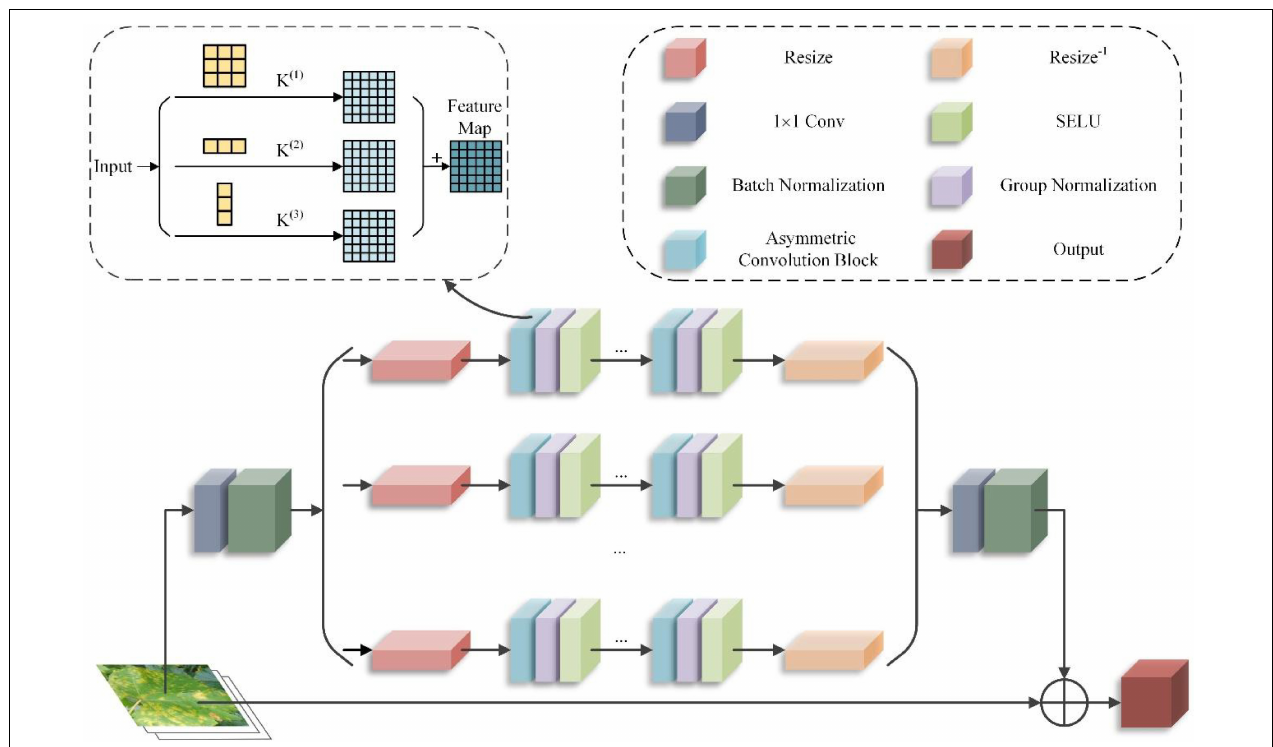
FIGURE 6 | Asymmetric multi-scale fusion module (AMFM)